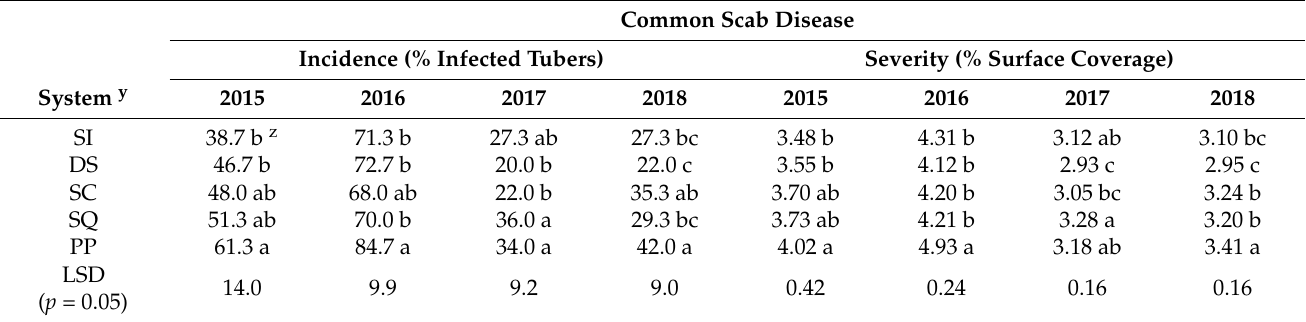
Table 5. Effect of different cropping systems on development of common scab (caused by Streptomyces scabies ) on potato tubers over four field seasons